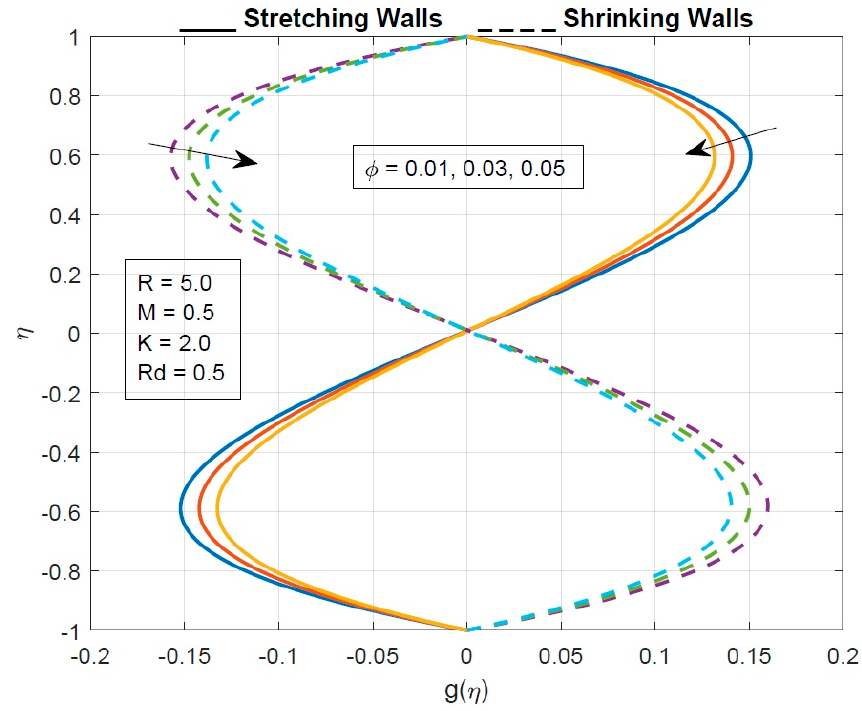
Figure 7. T he effect of the solid volume fraction on the micro-rotation profile.